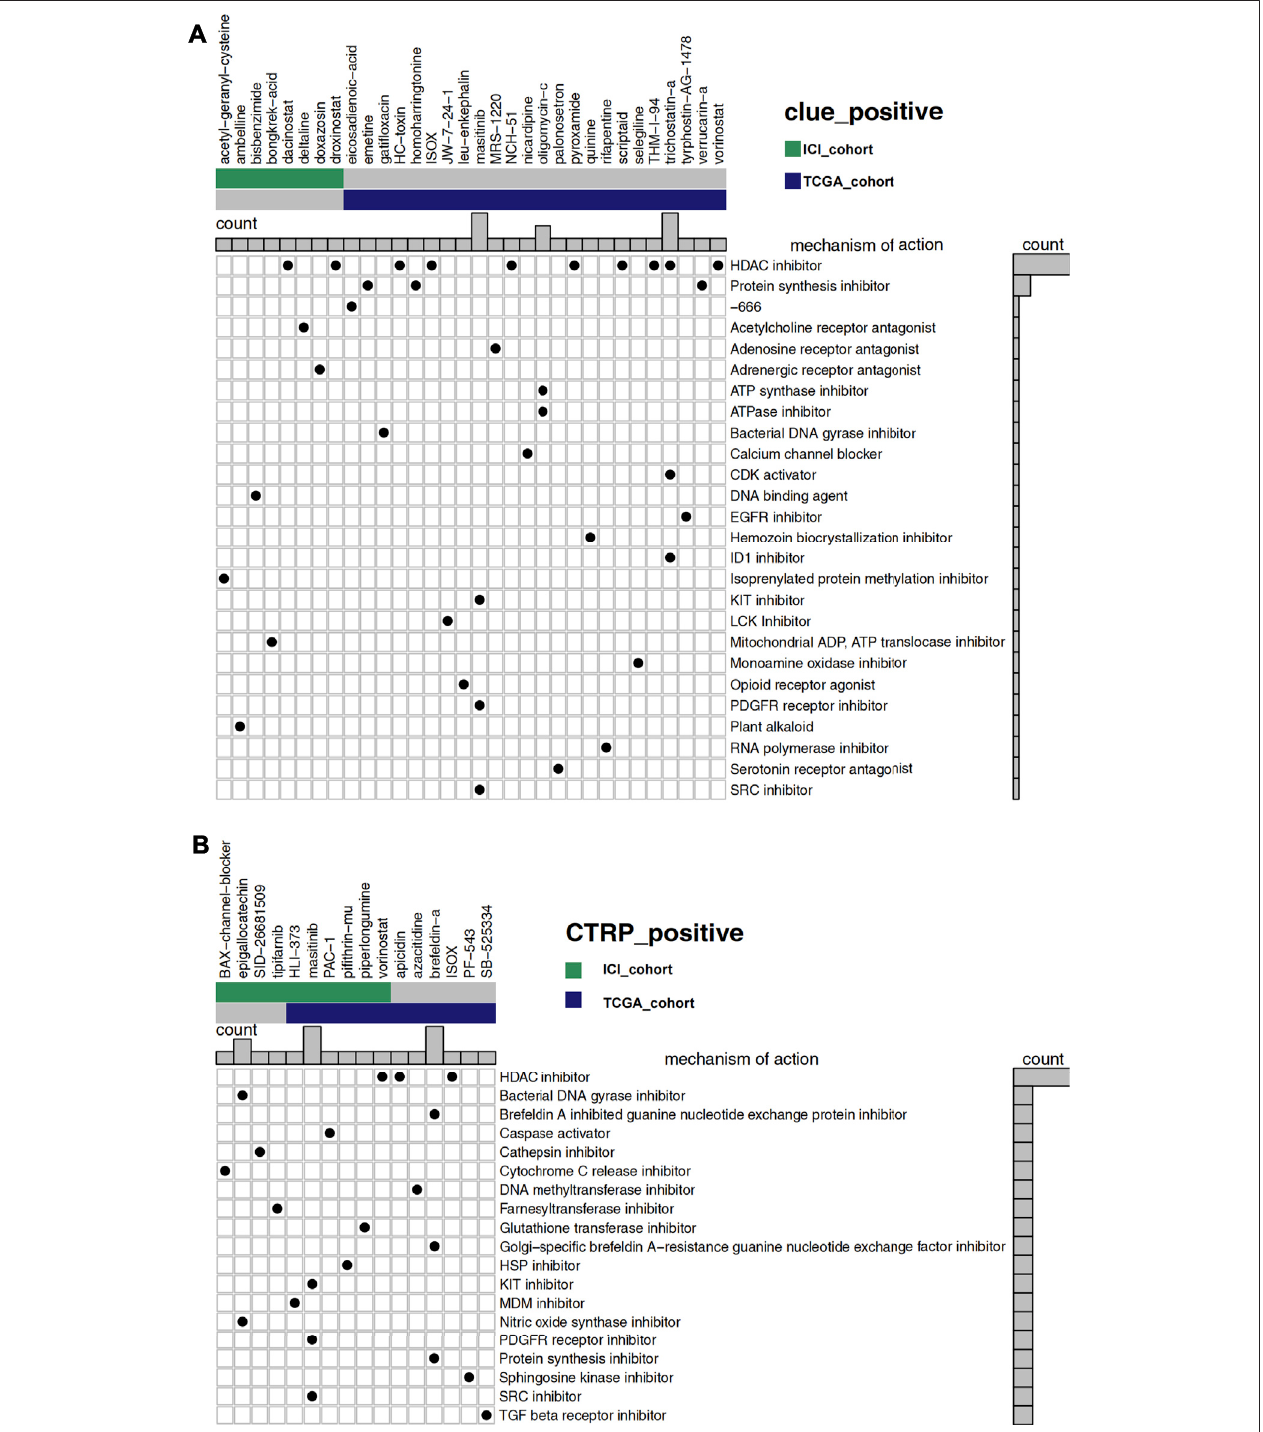
FIGURE 6 | (A) Thedegreeofsimilaritybetweentheexpressionpro fi lesofUCpatientsandthatofcelllinestreatedwithdifferentdrugs.IntheanalysisoftheCLUEdatabase,high- GMSpatientswereusedasthecontrolgroup,andapositivevaluerepresentsasimilartrendwhileanegativevaluerepresentsanoppositetrend.Thesimilarityisquanti fi edwithascoreof − 100to100.Thehighertheabsolutevalueofthescore,themoreobviousthetrend.The fi gureshowsdrugswithscoresabove60. (B) ThepredictedsensitivityofUCpatientstovarious drugs usingdata fromtheCTRPand CCLEdatabaseswhilethe drugsensitivity is quanti fi ed with AUC. Thelower the AUCvalue, thehigher thesensitivity tothe drug.The fi gure showsthedrugswhoseAUCvaluesweresigni fi cantlydifferentbetweenhigh-GMSandlow-GMSpatients(Wilcoxon ’ stest, p < 0.05).Inaddition,thecorrelationcoef fi cientsofthedrugs abovewithGMSweregreaterthan0.4,whichindicatedthatthesedrugsweremoresensitiveinpatientswithlow-GMS.Inthemainportionofthe fi gure,columnsrepresentdrugs,androws representthemechanismsofaction.Theblackdotsinthecorrespondingrectanglesindicatethatthedrugshavethecorrespondingmechanismsofaction.Thebarplotsonthetopand right of the fi gure re fl ect the frequency of black dots of the corresponding columns/rows.